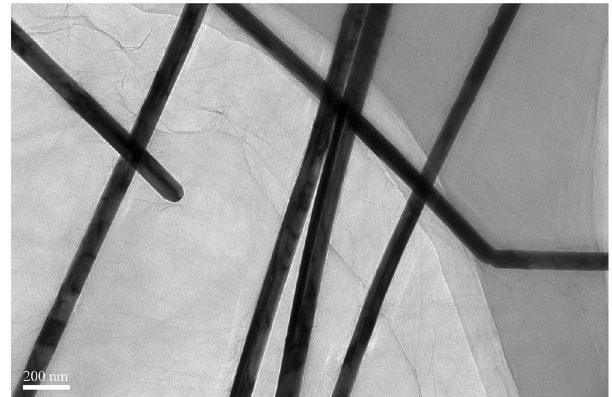
Figure 5. TEM image of the mixed solution with a volume ratio of graphite/AgNWs (1:1).